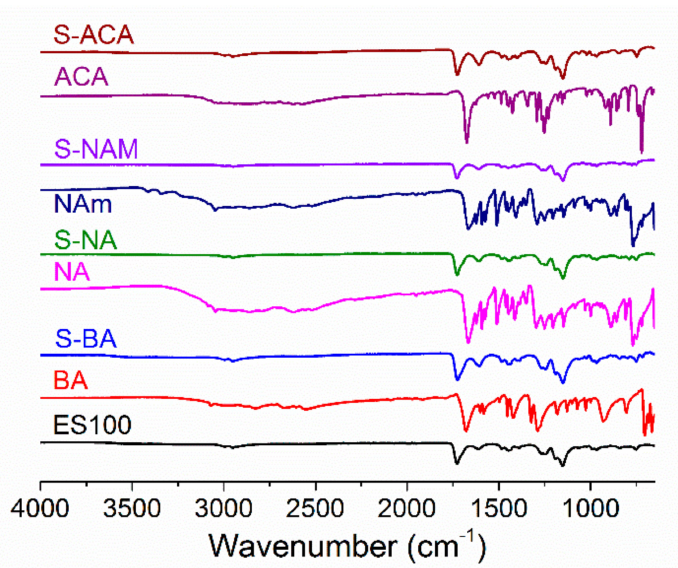
Figure 4. IR spectra of the monolithic fibers.